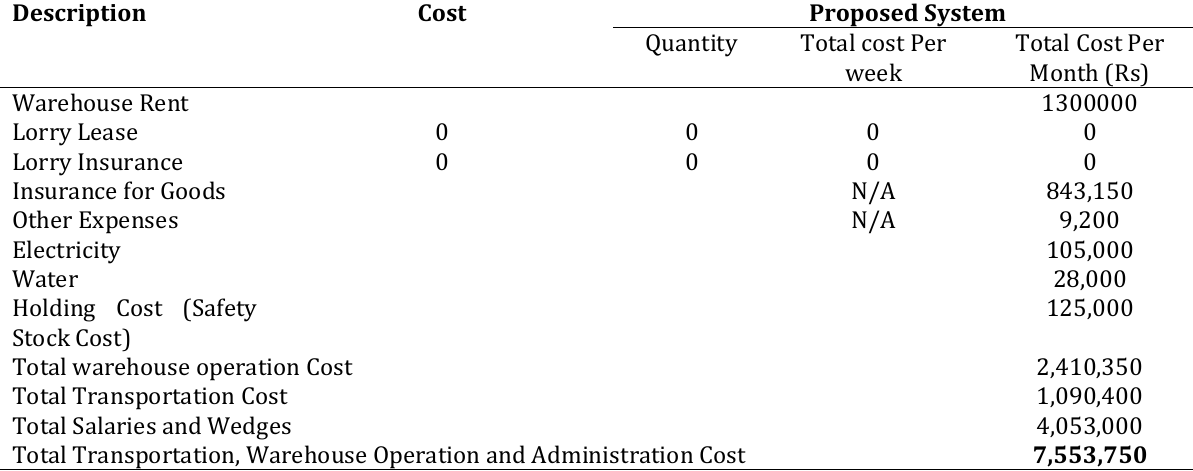
Table 11: Total transportation, warehouse operation and administration cost of the proposed system